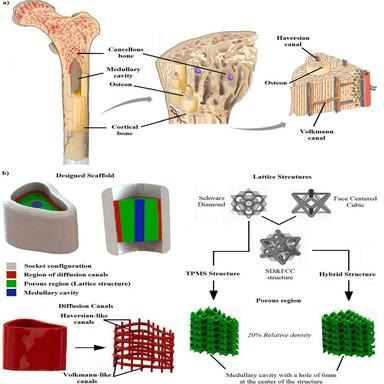
a) Indicative image of the internal bone structure coupled with the diffusion canals and cavities, (Copyright 2018 Elsevier publisher. b) Design stages of each configuration along with the structural region of the developed implant.